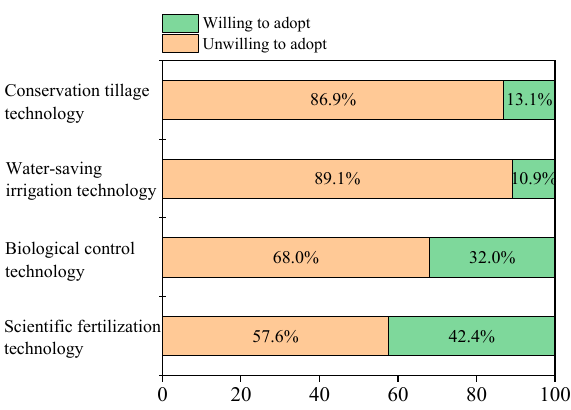
Figure 1. The demand for different green production technologies in food crops.